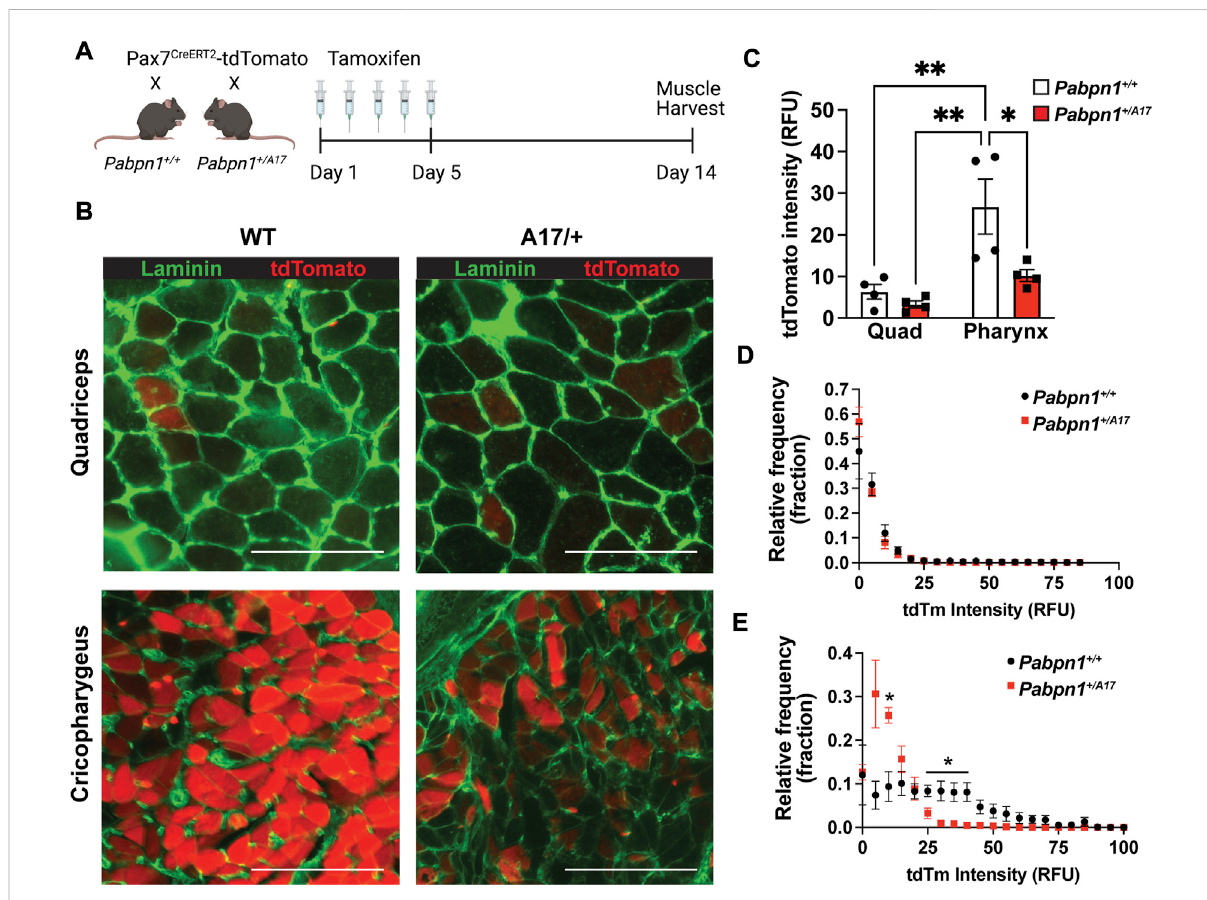
FIGURE 3 Pabpn1 +/A17 mice have impaired pharyngeal satellite cell fusion (A) Schematic of tamoxifen treatment plan for Pax7Cre ERT2 -tdTomato mice crossed with control or Pabpn1 +/A17 mice. Mice were treated with tamoxifen for 5 days at 2.5 months of age and harvested at 6 months of age. (B) Representative images of cross-sectioned quadriceps or cricopharyngeus muscles showing fi bers with recently fused satellite cells as tdTomato positive (red) and stained with laminin (green) to outline all fi bers. Bar = 130 µm. (C) Average tdTomato intensity in relative fl uorescence units (RFU) showing increased tdTomato intensity in cricopharyngeus (PH) relative to quadriceps (Quad) and a decrease in cricopharyngeal tdTomato intensity in Pabpn1 +/A17 relative to Pabpn1 +/+ mice. (D) Frequency distribution (fraction) of tdTomato intensity in myo fi bers in quadriceps muscles showingnochangein Pabpn1 +/A17 mice. (E) Frequencydistribution(fraction)oftdTomatointensityinmyo fi